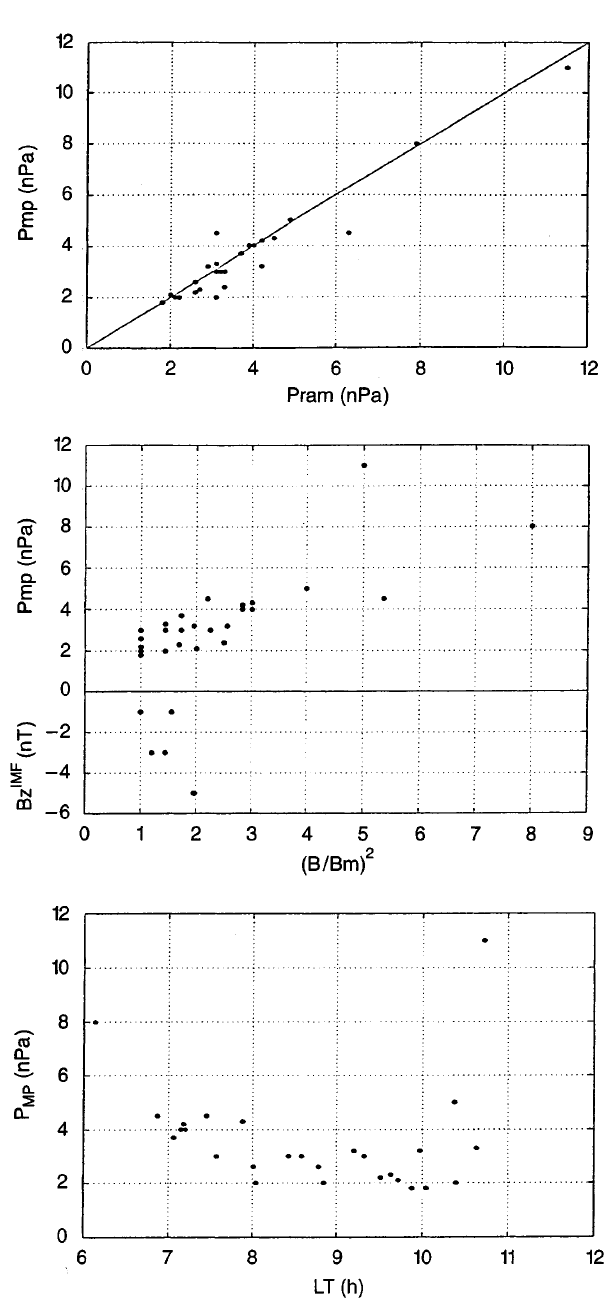
Fig. 2. a Correspondence between the measured P ram and fitted pres- sure values for crossings occurring during conditions with no B IMF correspondence between ( B = B m ) 2 and all crossings fitted to P MP and B IMF , c dependence of P MP on LT to indicate the biasing of crossing Z locations to intermediate pressures at low